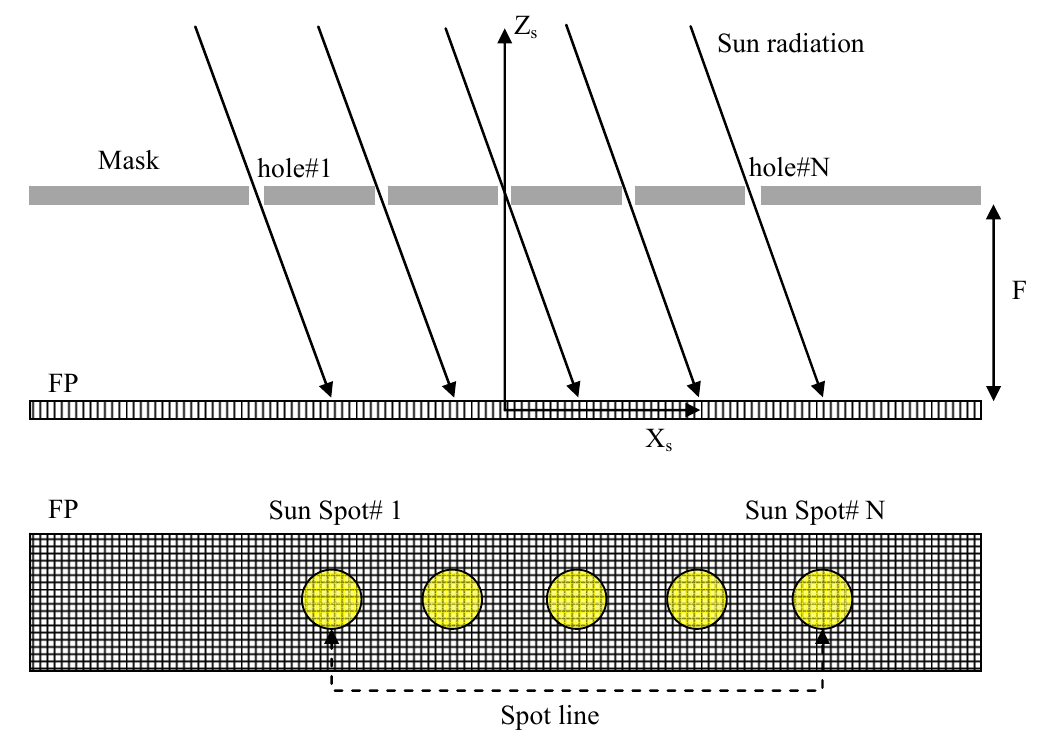
Figure 1. Sensor multi-spot operation concept (example of linear array of mask apertures for the sake of